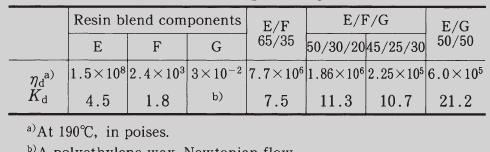
Figure 4 (left): Trend shown for polydispersity factor, Kd, with change of number-average molecular weight, Mn. Table 1: (right) Flow parameters η 0 and Kd of blends containing low molecular weight